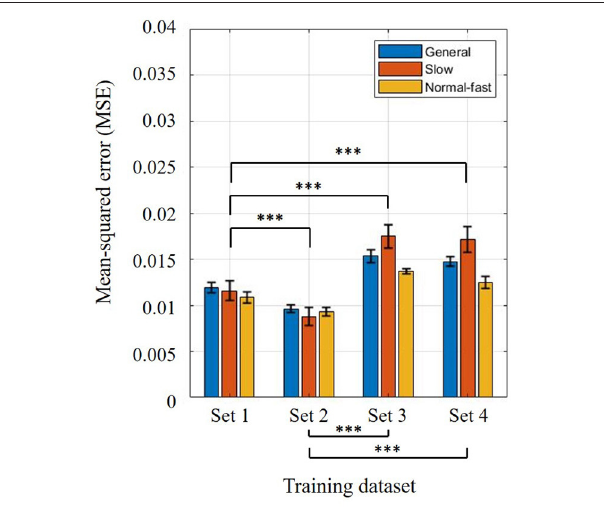
FIGURE 3 | Training results using four different training sets: (Set 1) angular positions and velocities of thigh and torso segments, (Set 2) angular position and velocity of thigh segment, and torso segment angular velocity, (Set 3) angular position and velocity of thigh segment, and torso segment angular position, (Set 4) position and velocity of thigh segment. Bar colors correspond to three different trained models: general, slow, and normal-fast walking. Bar graphs and error bars correspond to the mean and ±